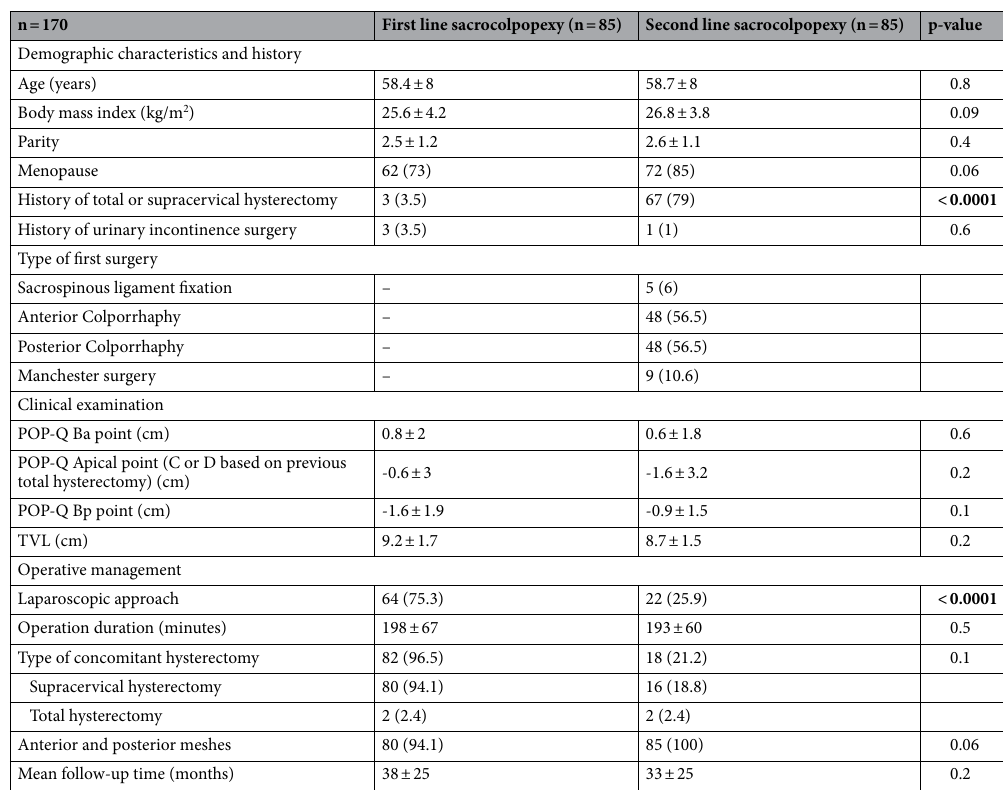
Table 1. Comparison of demographic, history, clinical examination, and surgericaly management characteristics between first line and second line sacrocolpopexies. Values are mean ± deviation standard or number of cases (percentage). n number of cases, cm centimeters, POP-Q pelvic organ prolapse quantification system, TVL total vaginal length. Significant values are in